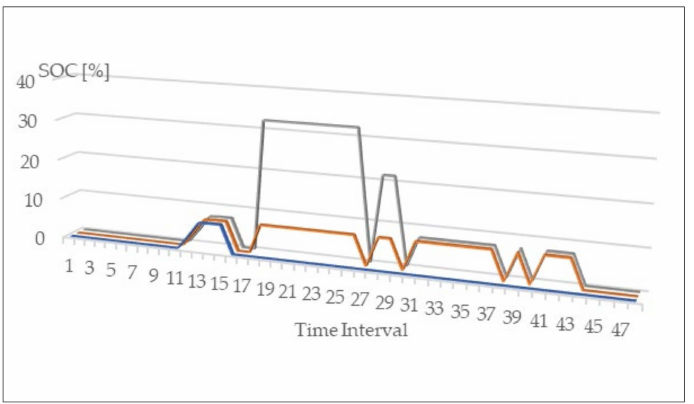
Figure 10. Mobility pattern 2—daily profile of upward flexibility: scenario (a) in blue, scenario (b) scenario in orange, and scenario (c) in grey.